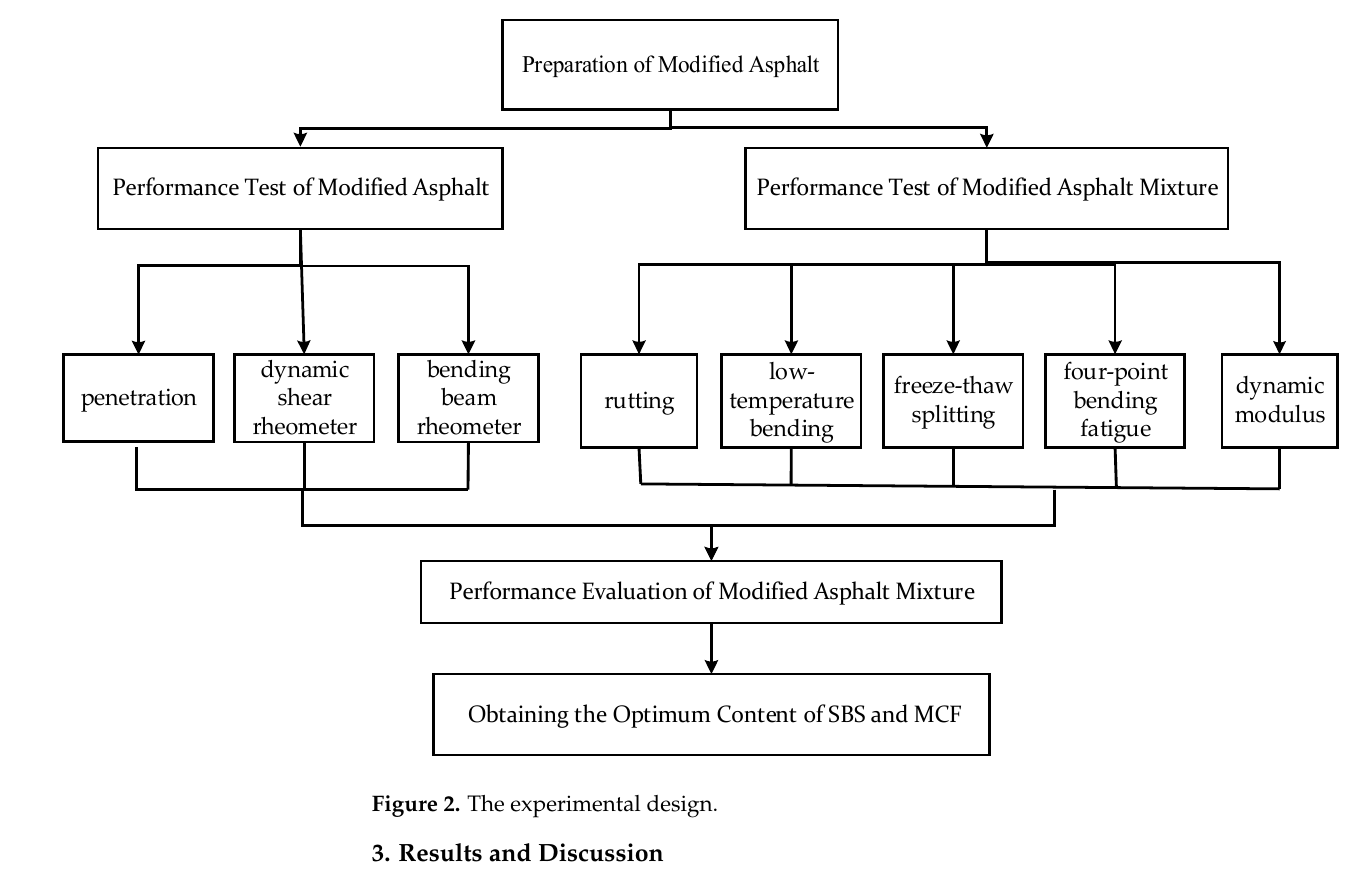
Figure 2. The experimental design.